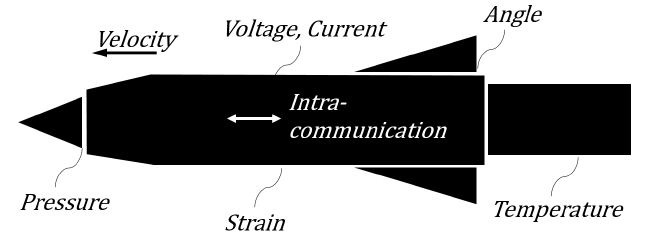
Figure 3. Types of data in a missile system. Each sensor or communication datum is digitized with a different sampling rate, and the time standard of the sensor or intra-communication data is different, so the data are out of sync. As a result, many data points are marked as not a number (NaN) or redundant values. the time intervals of the data are not uniform, and some values are redundant or NaN. Table 2. An example of missile data (sensor and